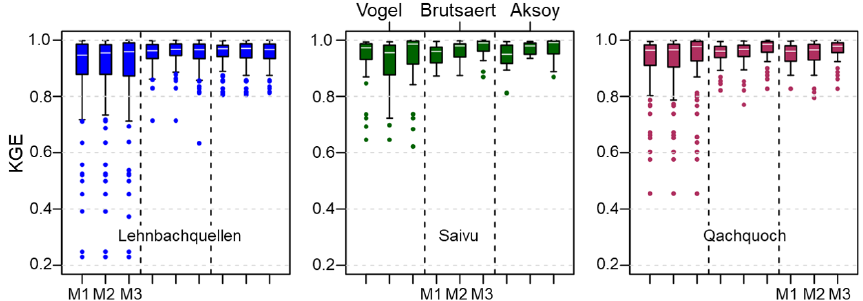
Figure 3. Boxplot of KGE measures between observed and simulated recession events based on parameters derived from the different REMs and POAs. The boxplots represent the interquartile ranges of KGE with the median shown in white lines and outliers marked in colored points.